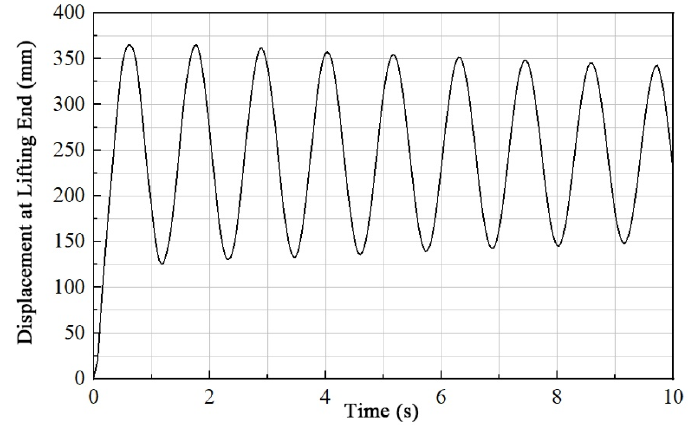
Figure 13. Displacement Response of the Lifting Arm at the Lifting End in the Second Stage.